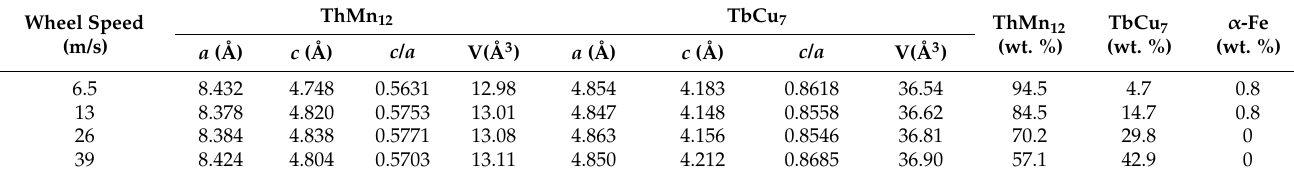
Figure 1. Refined X-ray diffraction patterns of the Sm(Fe 0.8 Co 0.2 ) 10 Si 2 melt-spun ribbons with different wheel speeds. Table 1. Lattice parameters a and c , c / a , and average atomic volumes (V, Å 3 ) of ThMn 12 -type and TbCu 7- type phases and weight fraction (wt. %) of ThMn 12 , TbCu 7 , and α -Fe phases in the Sm(Fe 0 . 8 Co 0 . 2 ) 10 Si 2 melt-spun ribbons with different wheel speeds. The values of lattice parameters have a confidence interval of ±0.005 according to the deviation from measurement and refinement.